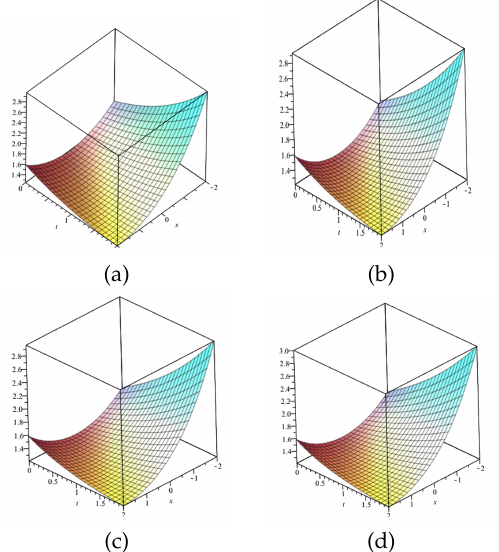
Fig. 1. Solution of Eq. (16) using the 3-iteration of DJM for several values of α when c=1 : (a) exact ( α =1) , (b) α =1 , (c) α =0.95 and (d) α = 0.9 .